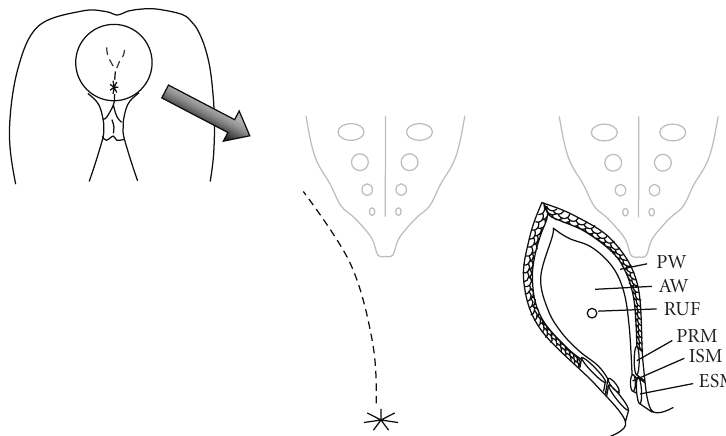
Figure 1: The York-Mason technique. PW: posterior wall of the rectum; AW: anterior wall of the rectum; RUF: rectourinary fistula; PRM: puborectal muscle; ISM: internal sphincter muscle; ESM: external sphincter muscle.